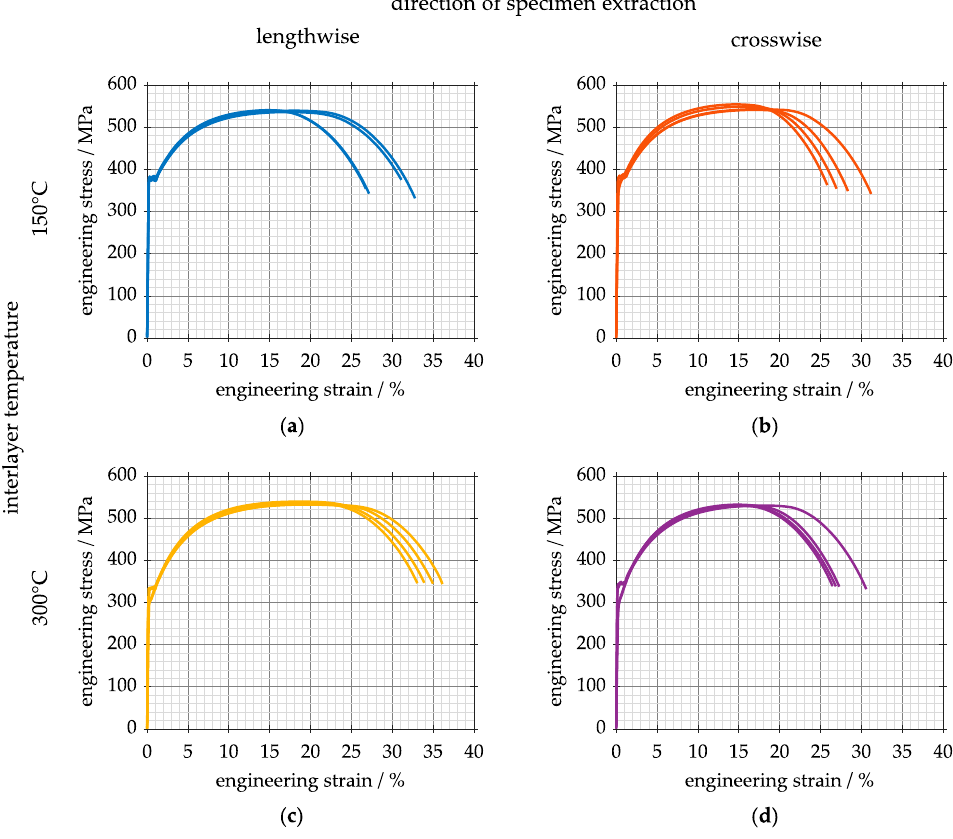
Figure 7. Stress–strain curves (engineering stresses and strains) from monotonic tensile tests at room temperature for interlayer temperature of 150 ◦ C for lengthwise ( a ) and crosswise ( b ) extraction direction and for interlayer temperature of 300 ◦ C for lengthwise ( c ) and crosswise ( d ) extraction direction. Table 2. Average and standard deviation (values in brackets) of monotonic properties at room tem- perature.